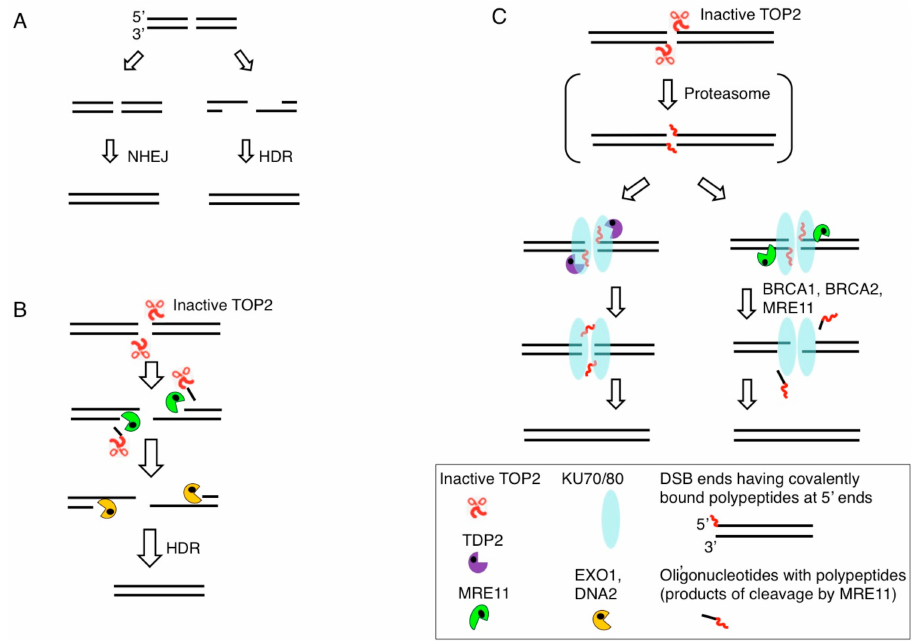
Figure 3. Removal of 5 (cid:48) TOP2 adducts. ( A ) DSBs are repaired by HDR or NHEJ. DSBs